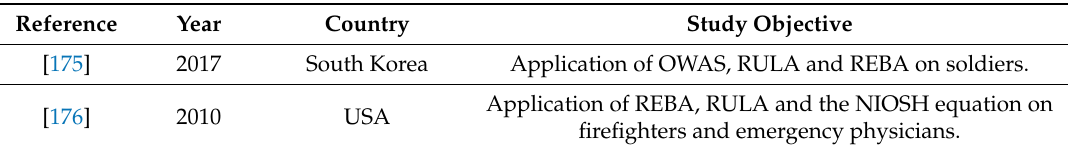
Table 15. Public administration and defence; compulsory social security.